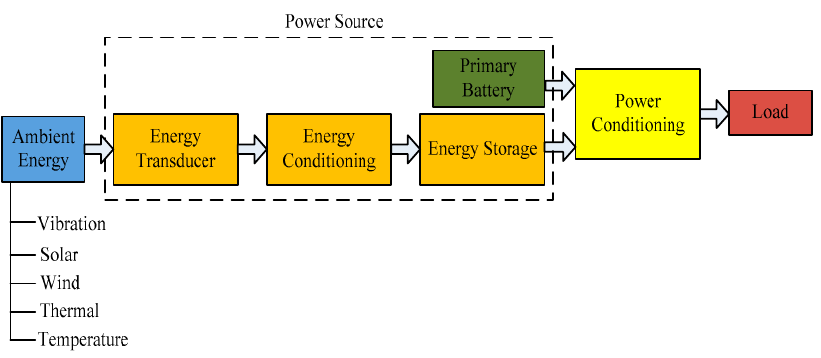
Figure 10. Block diagram power supply source of an ATS.